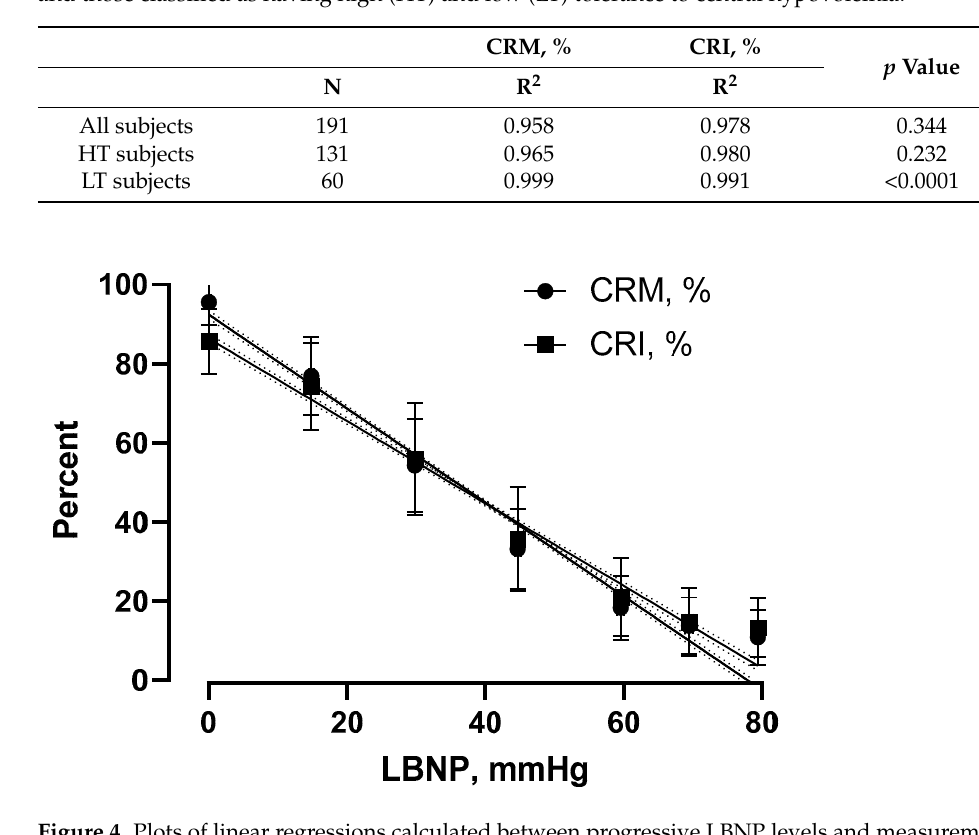
Figure 4. Plots of linear regressions calculated between progressive LBNP levels and measurements of compensatory reserve generated from CRM (circles) and CRI (squares) algorithms. Values are the mean ± SD calculated at the end of each 5 min step of LBNP from all 191 data sets presented in Figure 3 (upper panel).